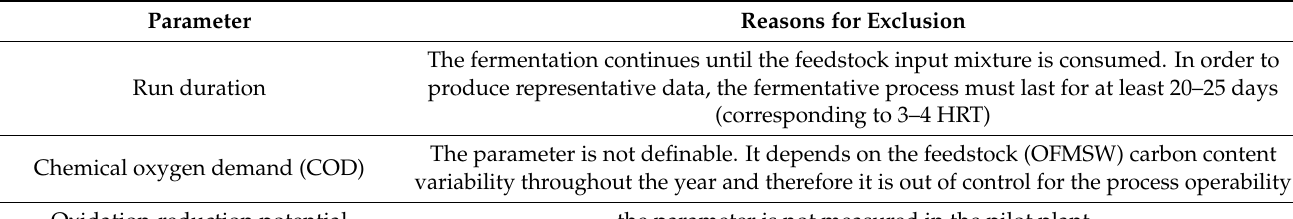
Table 6. Parameters not included in the BioHazOp analysis of node